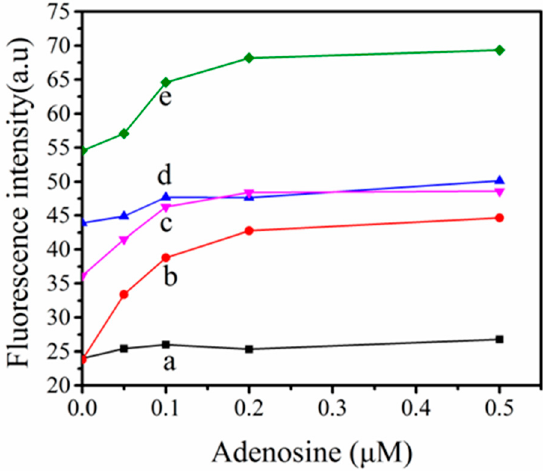
Figure 4. The fluorescent response toward the concentration of adenosine (0, 0.01, 0.05, 0.1, 0.2, and 0.5 μ M) under different ratio of TPE-2N+ and ABA concentration, a: 5:0.5; b: 10:0.1; c: 10:0.3; d: 10:0.5, and e: 20:0.5.